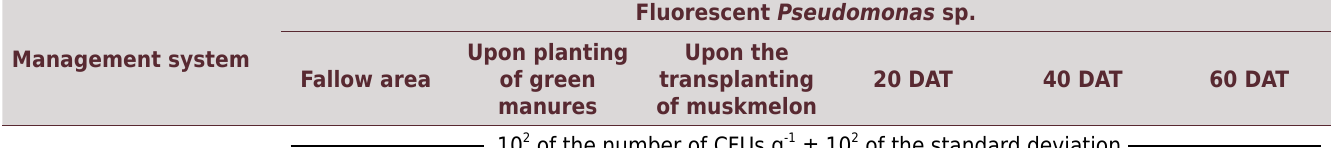
Table 4. Number of colony forming units (CFUs) of fluorescent Pseudomonas sp. in the no-tillage and in the conventional tillage systems in different management systems and soil sampling times